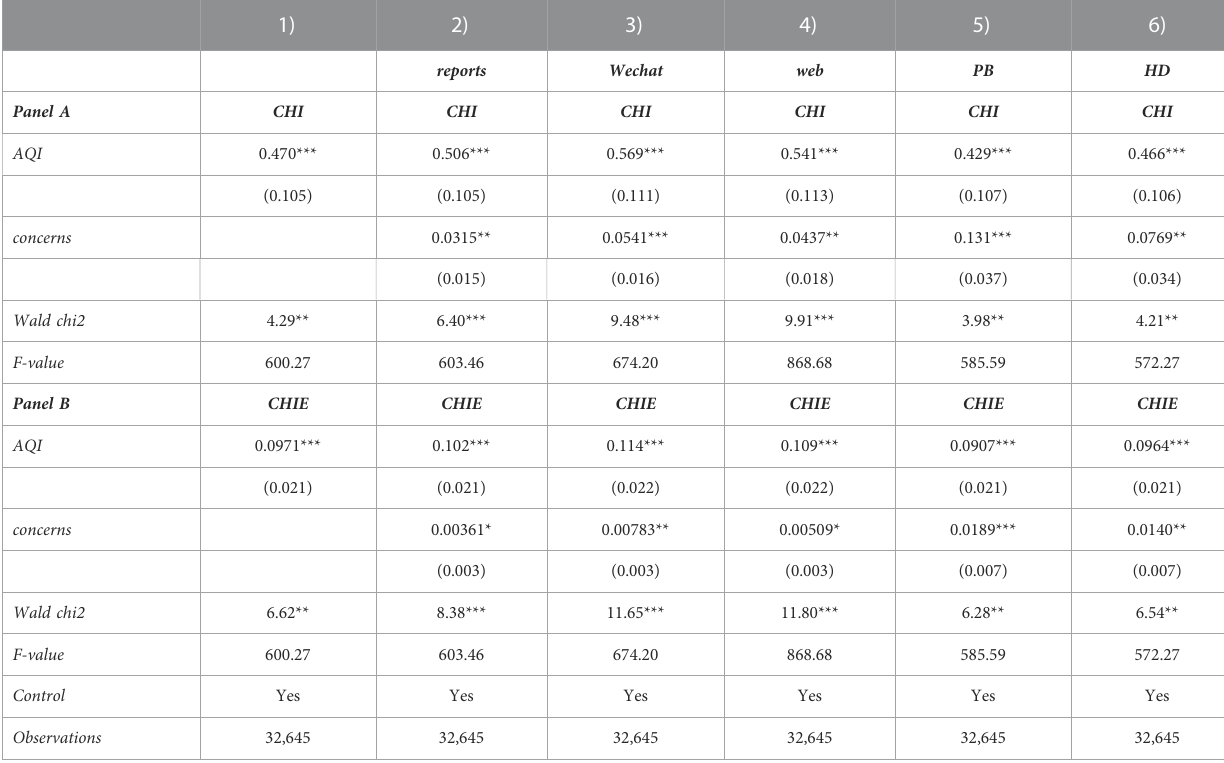
TABLE 6 Regression results after replacing the independent